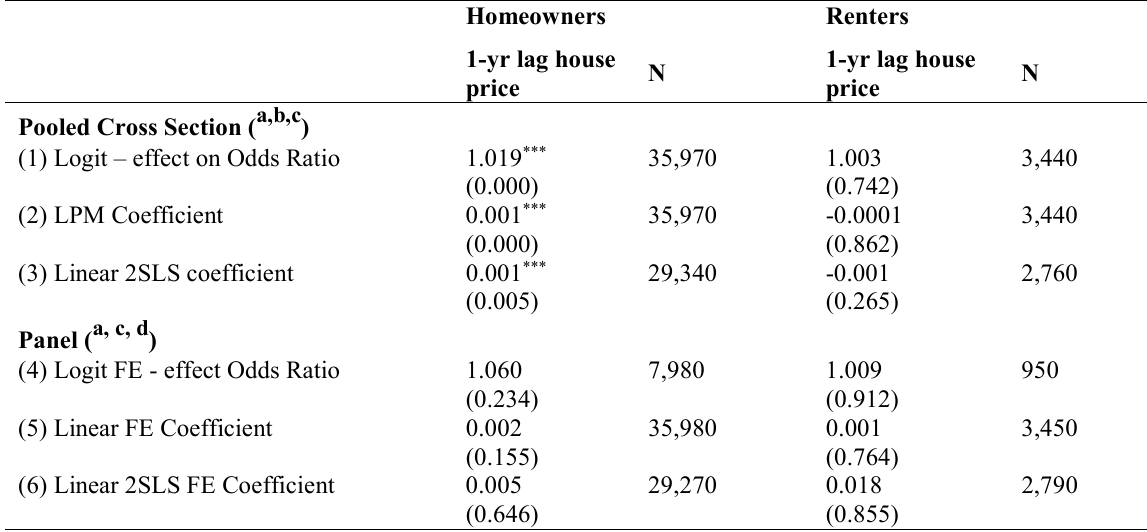
Table 4: Effect of house prices on marginal fertility of owners and renters (including movers outside REB, p-values in